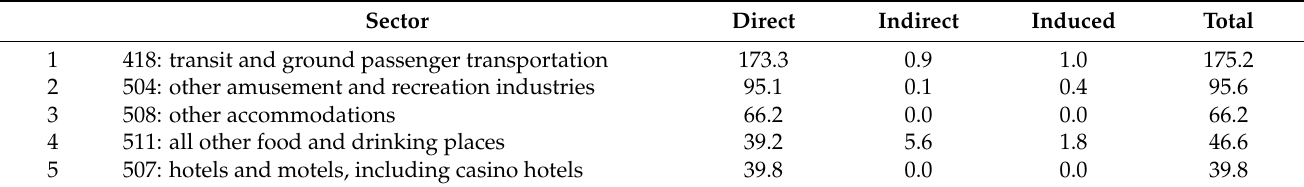
Table A25. Top Five Affected Sectors by Employment.